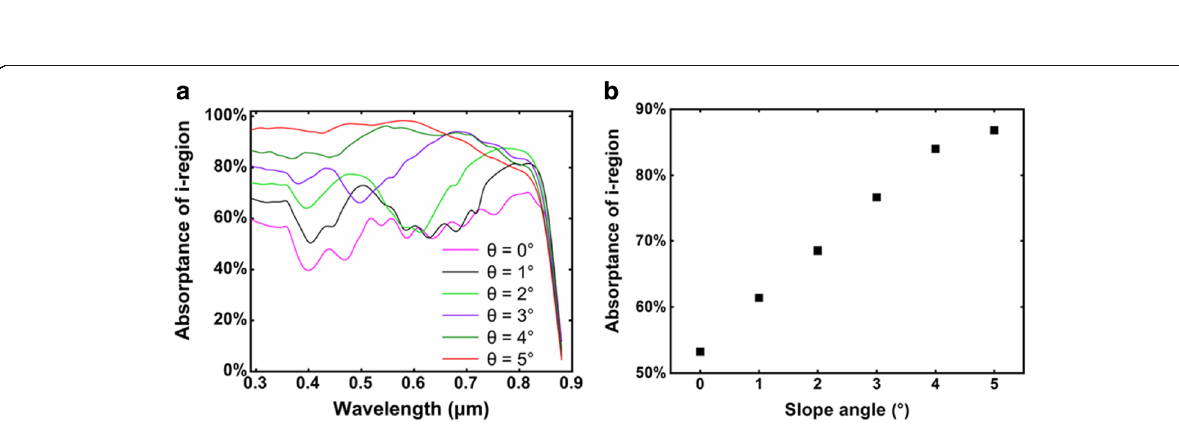
Fig. 4 a Wavelength-dependent absorption spectra of the i-region. b The AM1.5G-weighted integral of the absorption spectra of i-region in